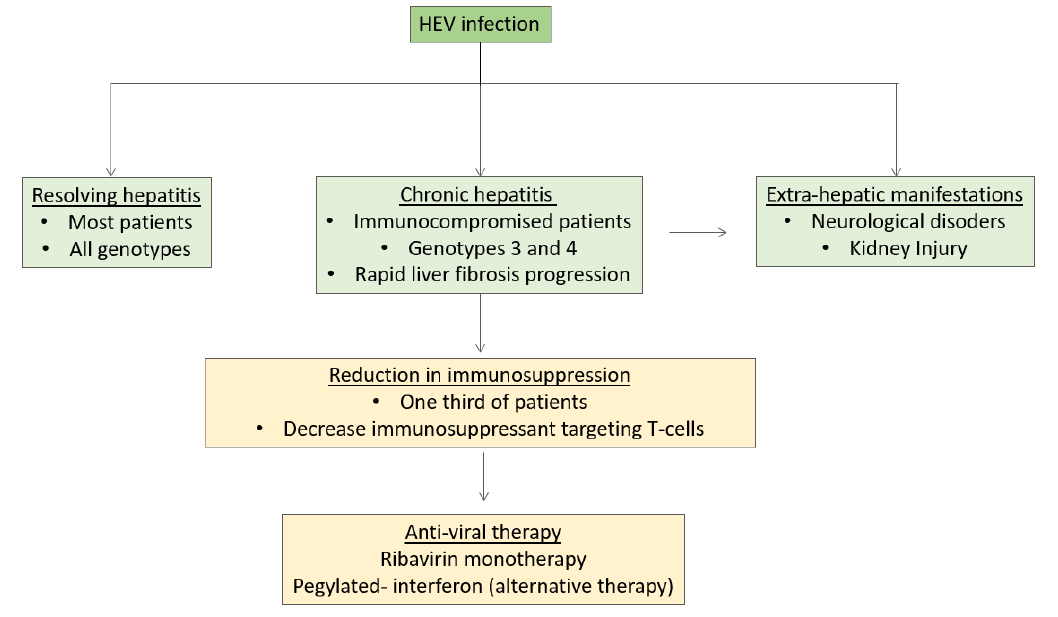
Figure 1. Natural history and management of hepatitis E.